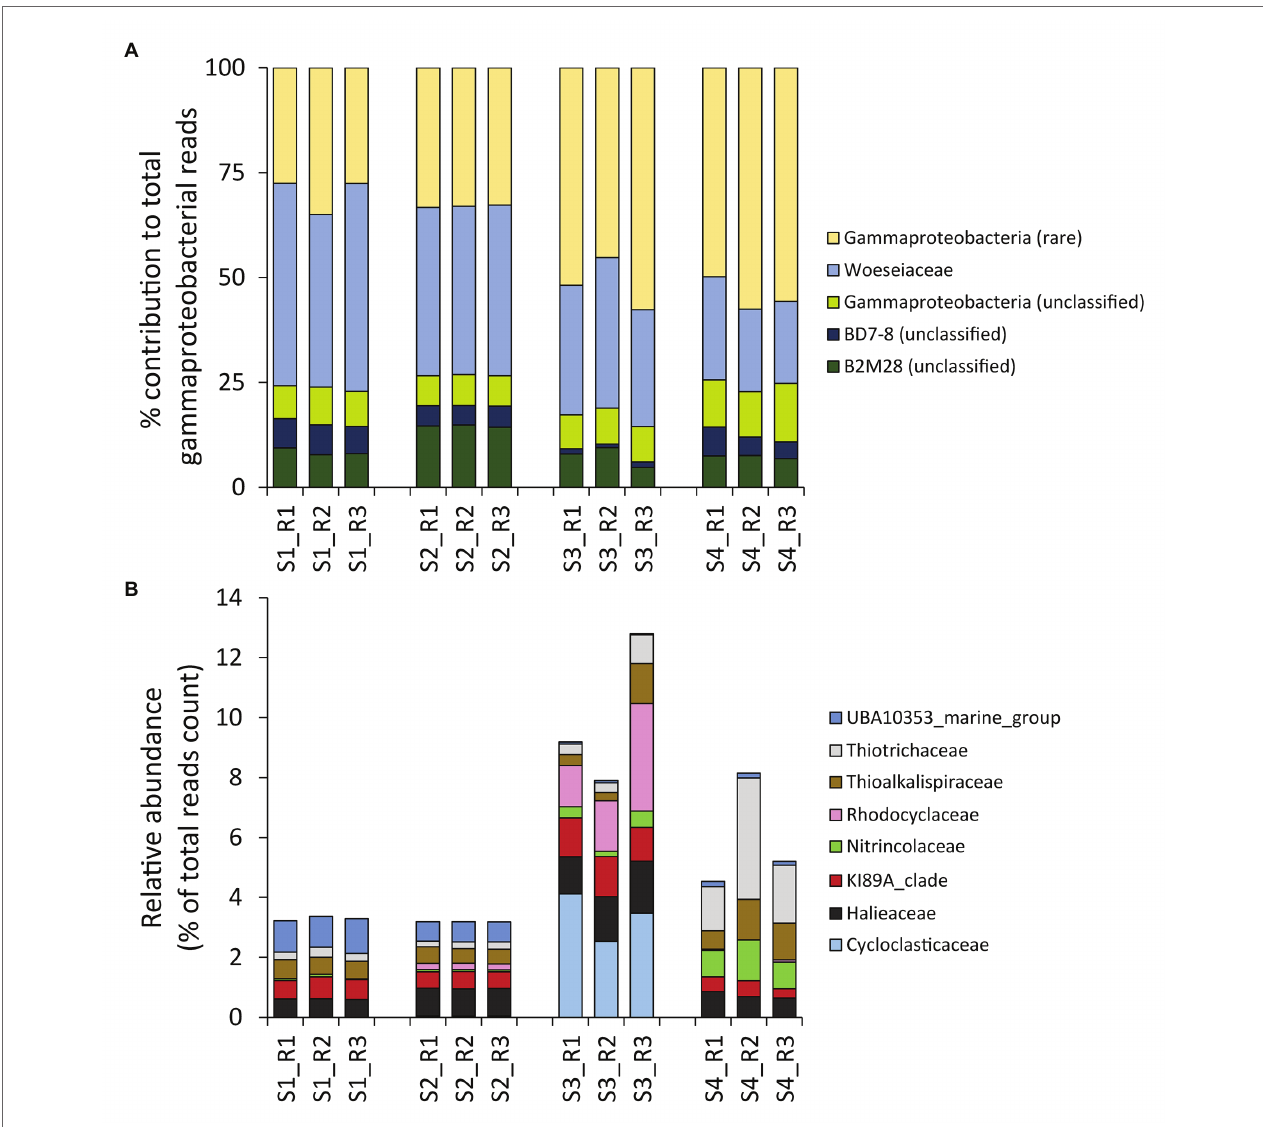
FIGURE 4 | (A,B) Composition of benthic bacterial assemblages affiliated to the class Gammaproteobacteria. Reported is (A) the contribution of each identified gammaproteobacterial Family within the Gammaproteobacteria Class (expressed as percentage), and (B) , a highlight on the eight gammaproteobacterial families that resulted rare within the dataset (i.e., on average contributing for less than 1% to the overall reads count across samples), but displayed peaks with relative contributions >1% in some